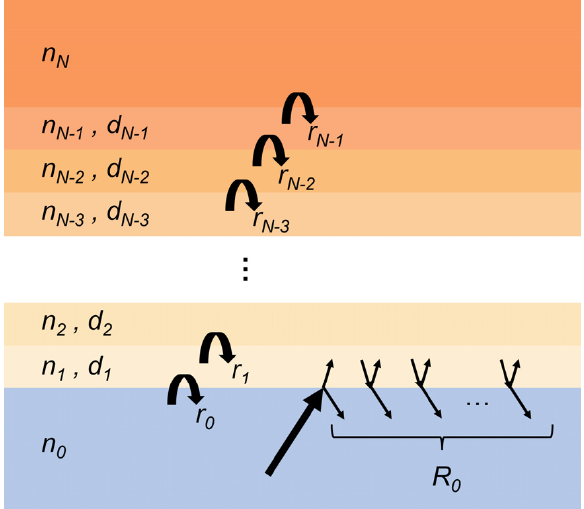
Figure 10. Schematic diagram of the multiple layer structure and the derivation of the reflection coefficient based on the Fresnel equations. n m ( m > 0) is the refractive index of the m th layer calculated using an EMT. d m is the thickness of the m th layer. r m is the reflection coefficient from medium m to m + 1. R 0 is the reflection of light incident from medium 0 to the N-layer structure.